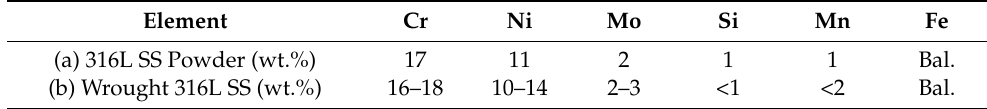
Table 1. Main elements of the chemical composition of the wrought 316L SS and the powder used for AM [26,27].